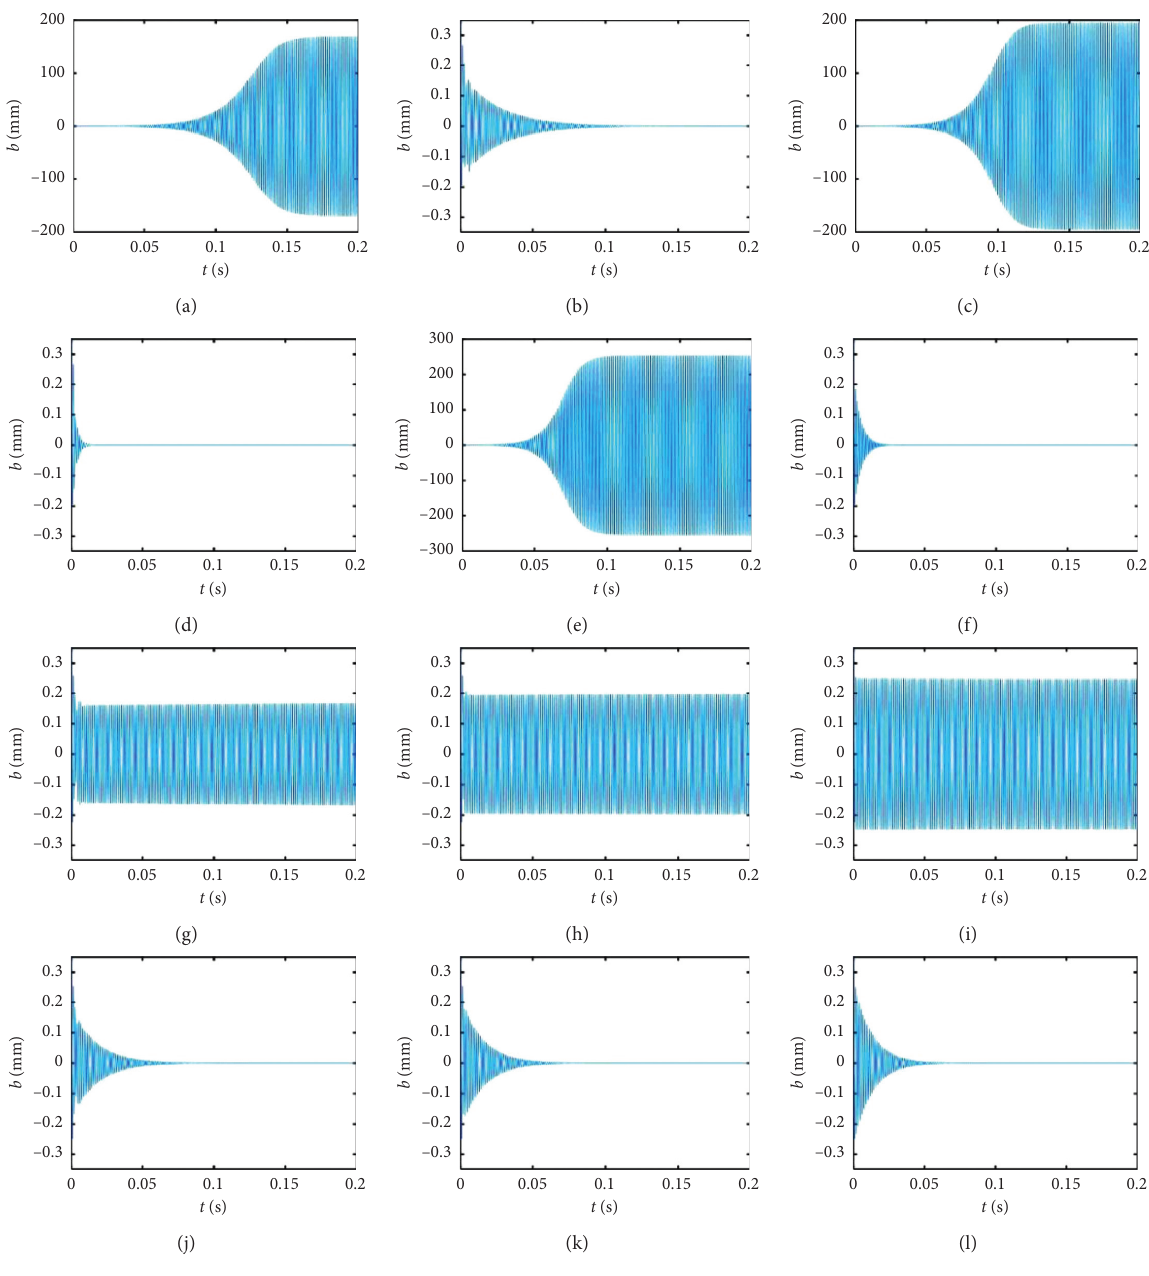
Figure 4: Time-history response curves at these parameter